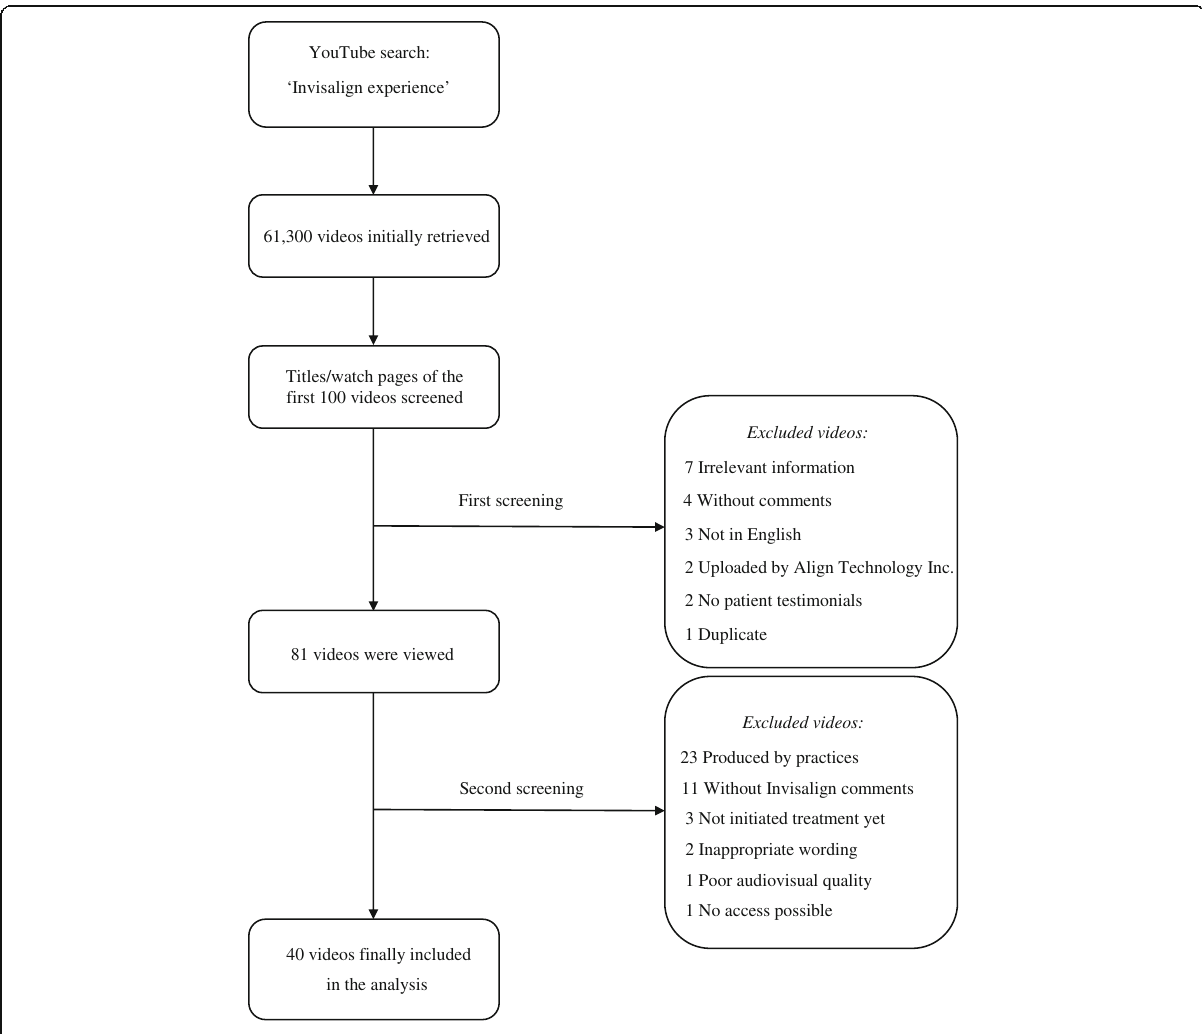
Fig. 1 Flowchart diagram of the selection process